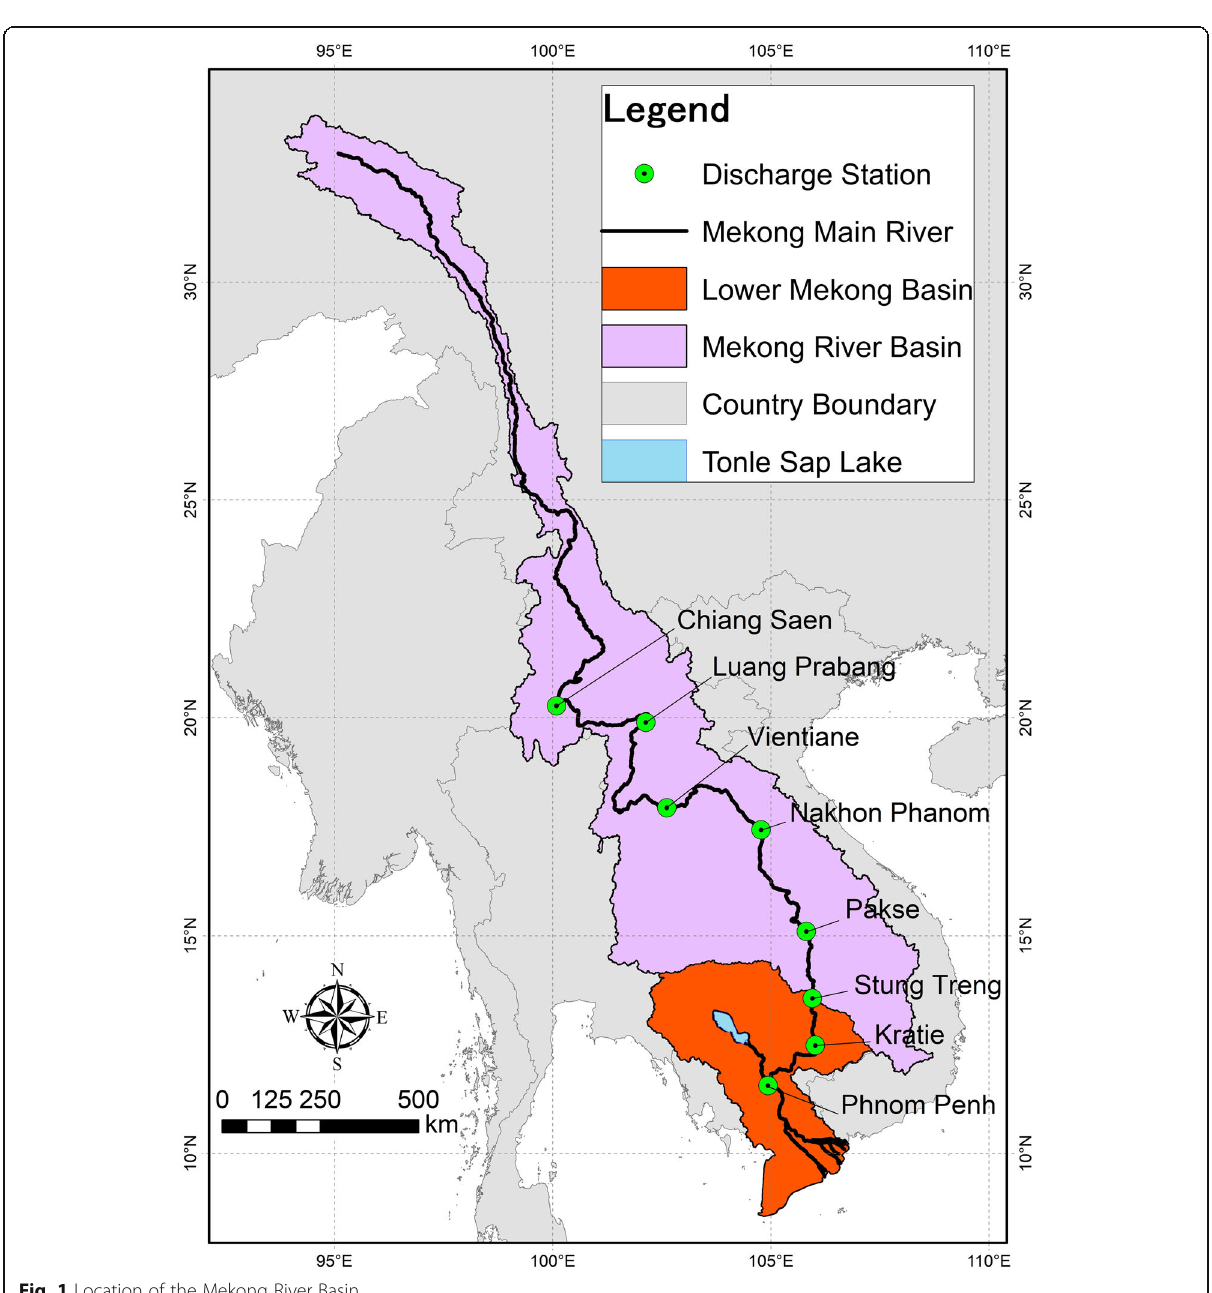
Fig. 1 Location of the Mekong River